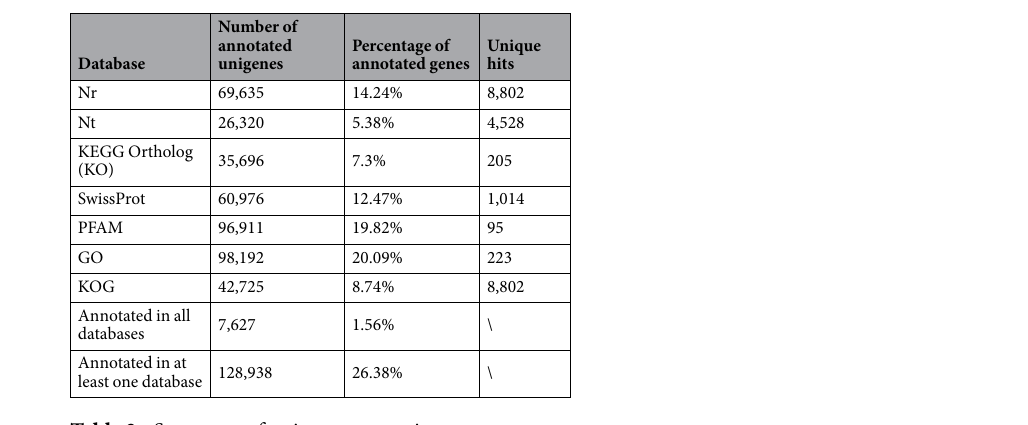
Table 2. Summary of unigene